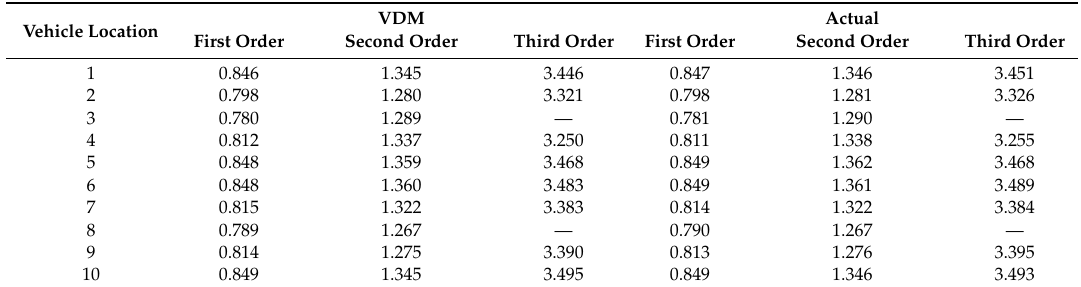
Figure 16 . Damage extents of the substructures. Figure 17. Damage identification results using 1-DOF vehicle model. Table 3. First four natural frequencies (Hz).